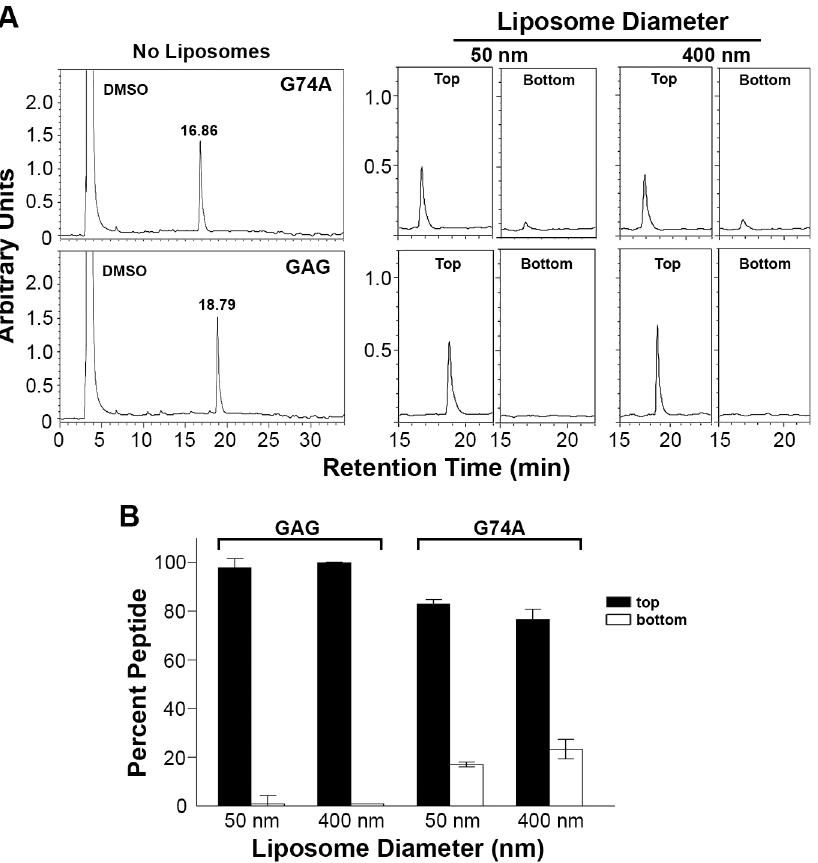
Fig 6. Mutant p15HPpep containing substitutions that disrupt the helix-loop-helix conformation partition into liposome membranes indiscriminate of membrane curvature. (A) Purified mutant p15HPpep peptides (G74A and G74/76A [GAG]) dissolved in DMSO were resolved by reverse-phase HPLC using a water:acetonitrile gradient and eluted with the indicated retention times (left panel). Peptides were mixed with liposomes (1:1:1 DOPC:DOPE:cholesterol) of the indicated diameters at a fixed peptide:lipid molar ratio (1:500) and liposomes were separated from free peptide by flotation on sucrose gradients. Peptides present in the top liposome and bottom free peptide fractions were detected by HPLC (right panel). Chromatograms from a representative experiment are shown in arbitrary fluorescence units at the same scale. (B) The liposome (top) and free peptide (bottom) sucrose fractions were analyzed by HPLC as in panel A, and the relative peptide concentration in each fraction quantified by integrating the area under the peak in the HPLC chromatograms. Percent peptide = Area Top / Total Area Top+Bottom . Bars represent the mean SEM of three experiments.